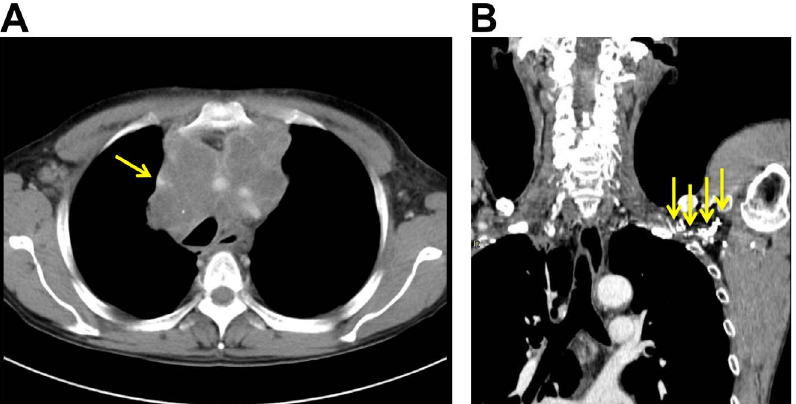
Figure 2. Examples of anticipated preoperative difficulties with the procedure confirmed on CT scan images. ( A ) SVC syndrome. Arrow indicates the excluded SVC by a tumor. ( B ) Tortuous collateral blood circulation. Arrows indicate the contrast-enhanced tortuous collateral blood circulation attributable to a modification caused by surgery, radiation, or spontaneous occlusion. doi:10.1371/journal.pone.0091335.g002 PLOS ONE |